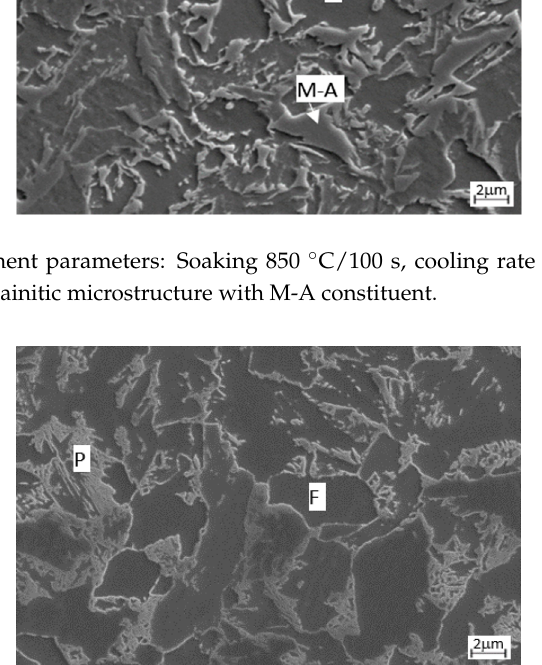
Figure 14. Heat treatment parameters: Soaking 850 °C/100 s, cooling rate 30 °C/s, bainitic hold 500 °C/600 s. Ferritic-pearlitic microstructure.